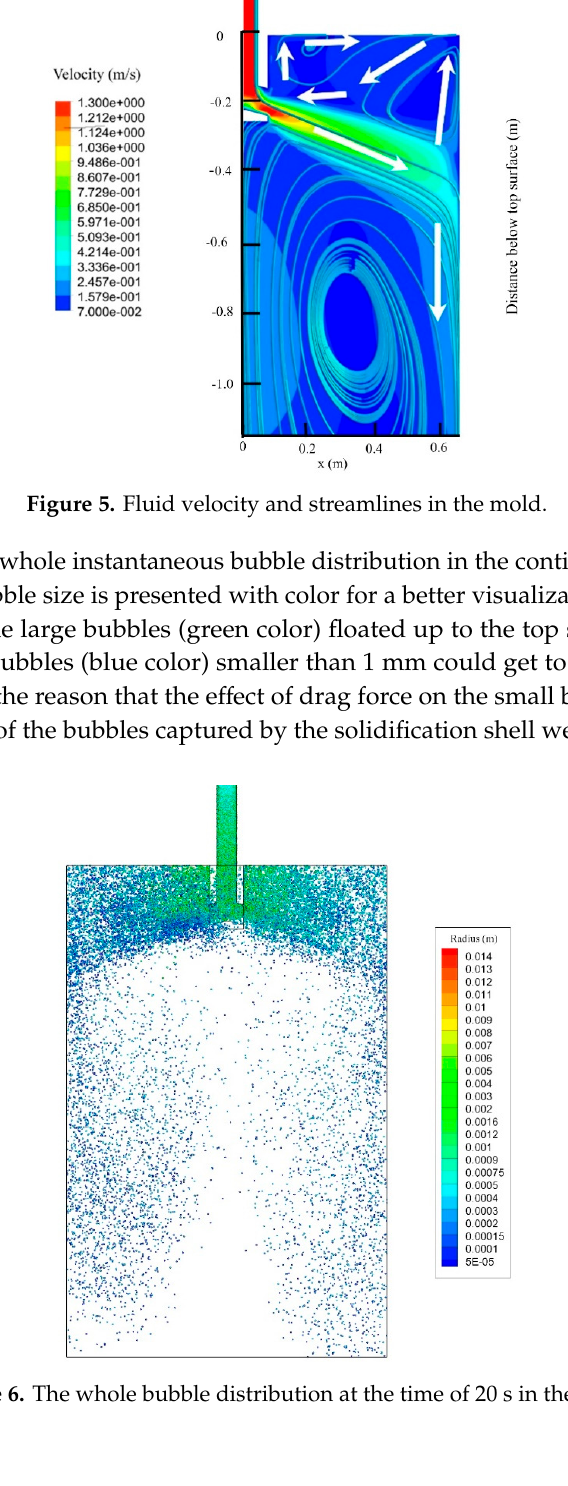
Figure 6. The whole bubble distribution at the time of 20 s in the mold.